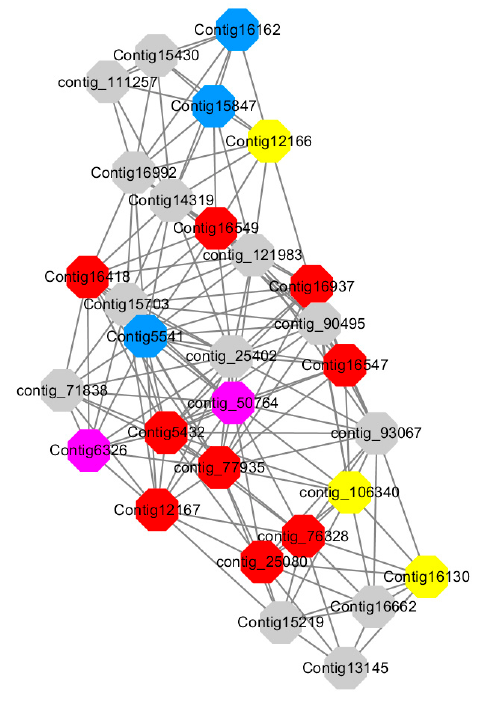
Figure 17. GCN of Module 5.